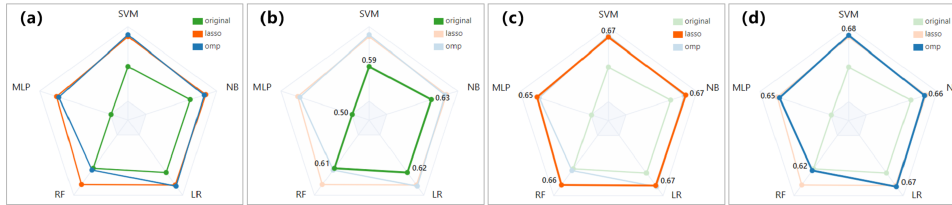
Figure 6. AUC values for five classification algorithms. ( a ) shows the composite comparison and ( b – d ) show the specific AUC values for the different methods, i.e., original, Lasso, OMP.